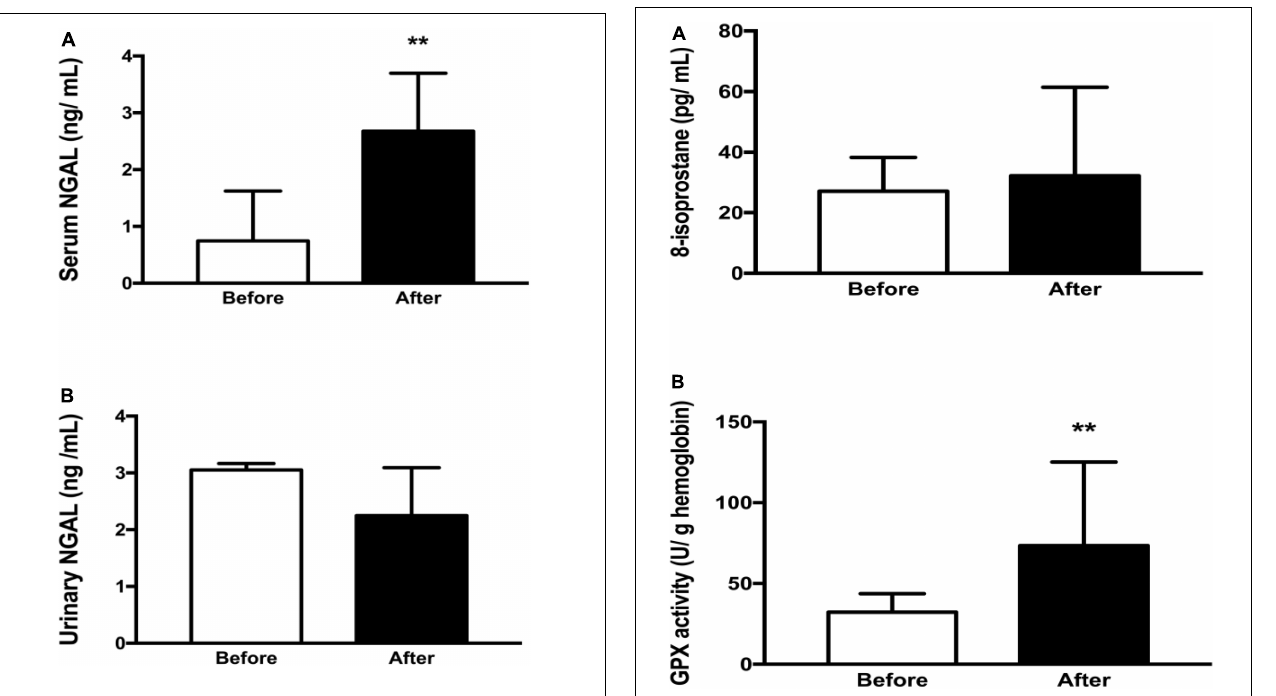
Frontiers in Physiology |